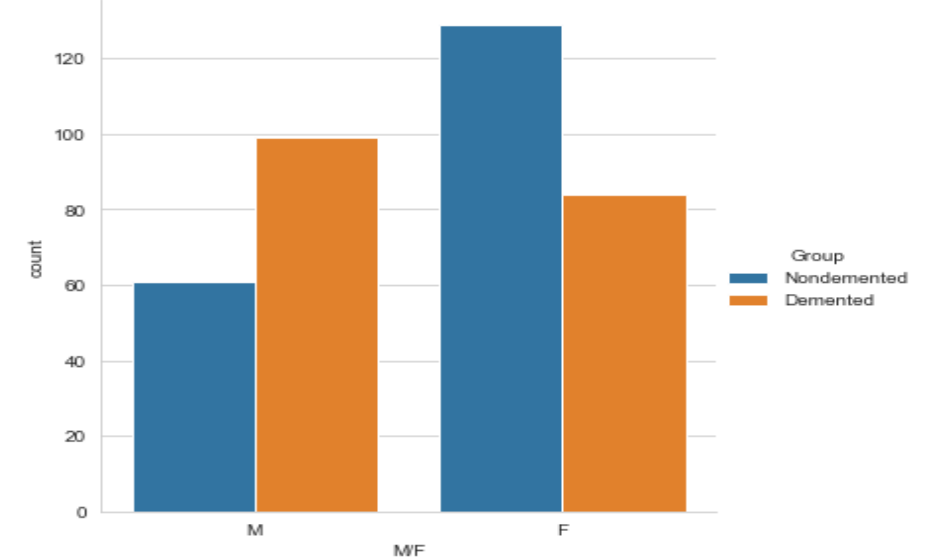
Figure 4. Comparison of ‘M/F’ and ‘Group’ w.r.t Non-Demented and Demented.